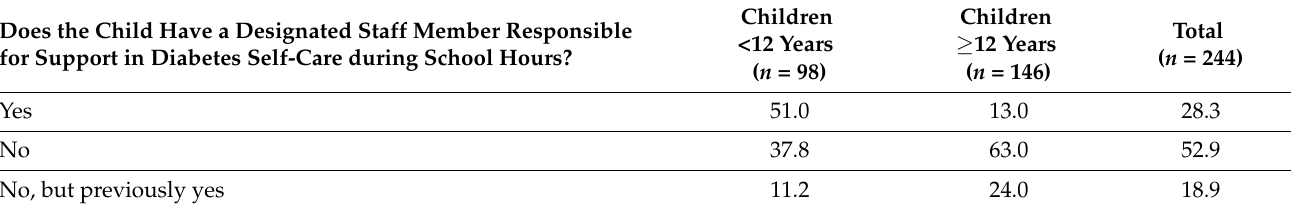
Table 3. Proportion of children (above or below 12 years of age) having a designated staff member with responsibility to support diabetes self-care. The results are presented in frequencies (%).